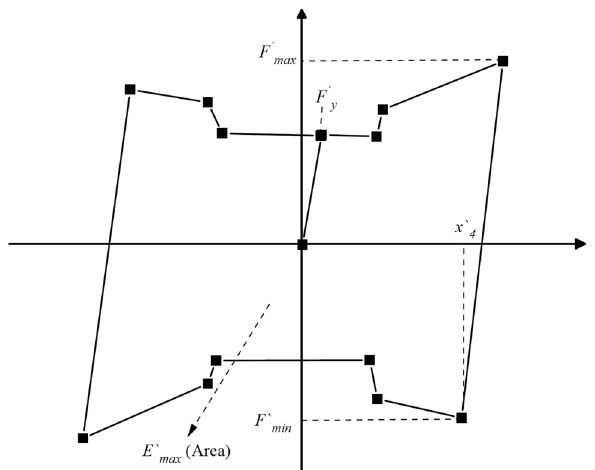
Fig. 12 5 indices quantifying fitting quality